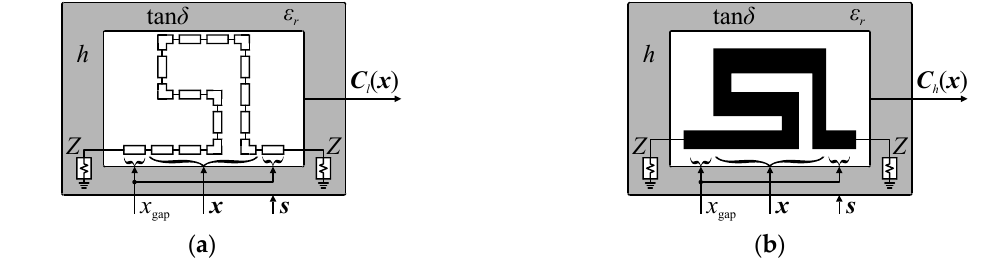
Figure 1. Conceptual illustration of a compact cell (here, in horizontal configuration): ( a ) low-fidelity model C l ( x ) and ( b ) high-fidelity EM-based model C h ( x ). Response of the cell is controlled using input variables vector x , whereas parameters x gap and s = [ Z H h ε r t tan δ ] T maintain separation between adjacent cells and control simulation conditions.